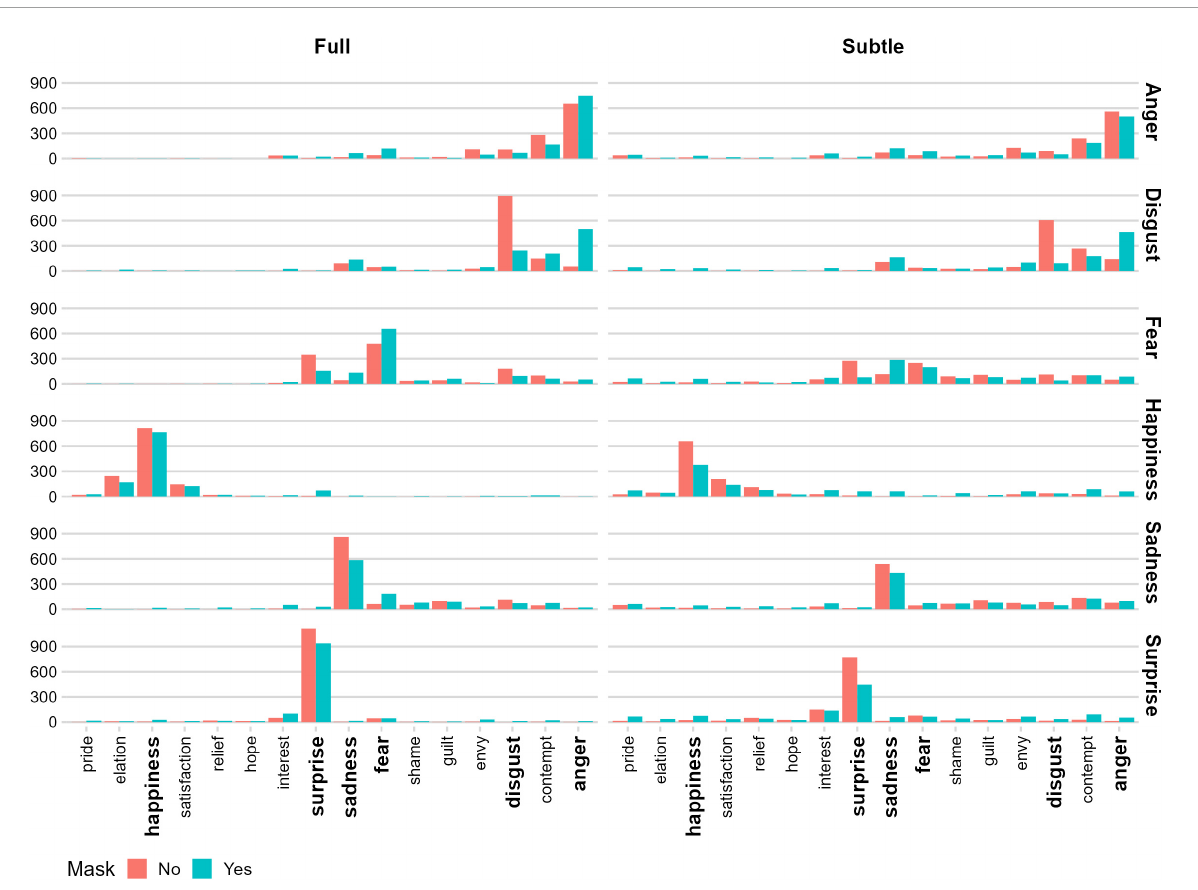
FIGURE2 GEW responses as a function of displayed Emotion, Mask, and Facial Expression Intensity. Each participant’s response was classified according to the position on the GEW to assign a label. The order of the X -axis corresponds to the clockwise order of the GEW. The Y -axis represents relative frequencies in each